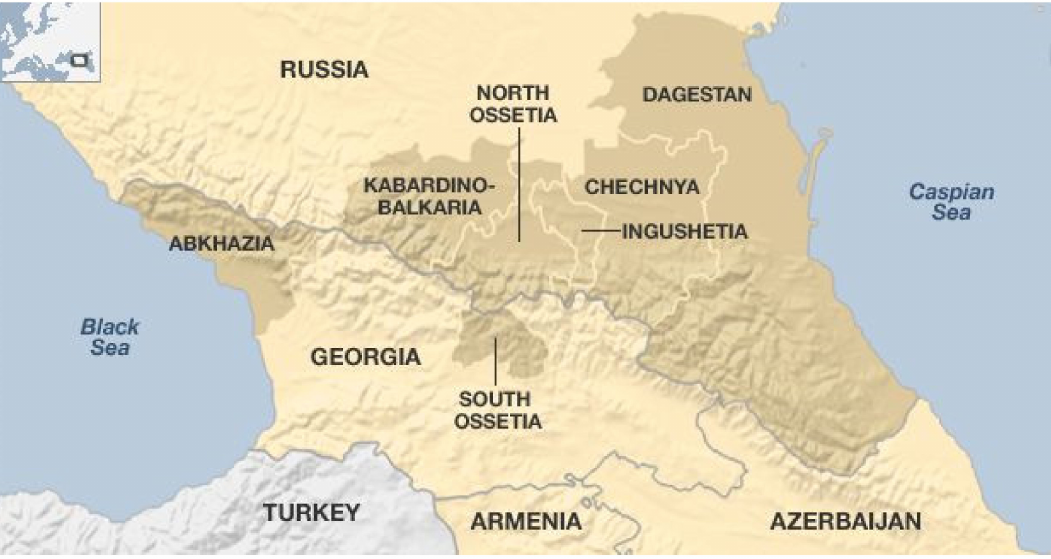
Figure 1. North Caucasus